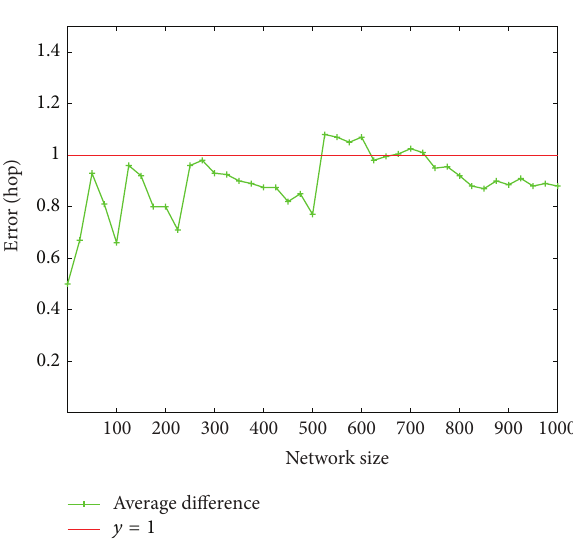
Figure 6: Error distribution for 1000